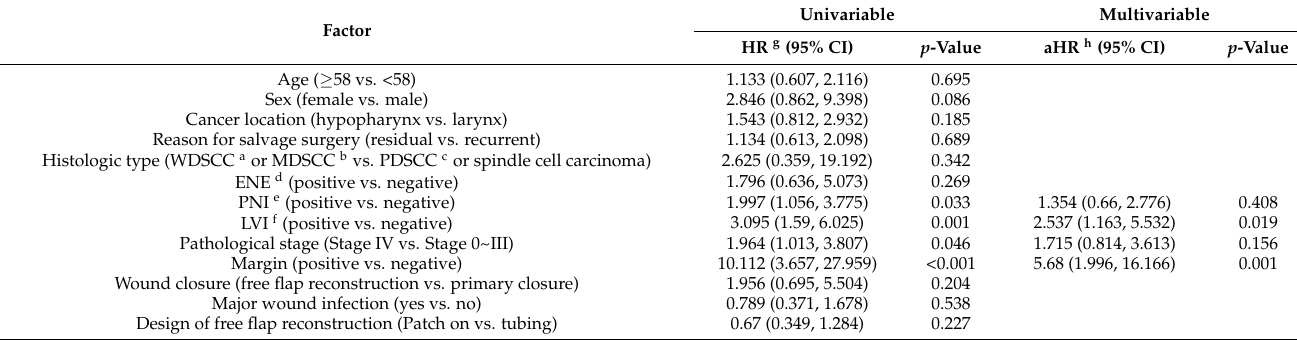
Table 2. Univariate and multivariate Cox regression analysis of prognostic factors associated with overall survival. Factor